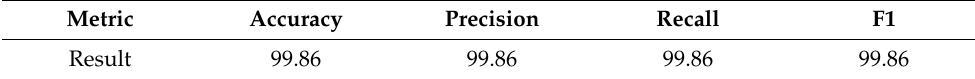
Table 1. Overall performance results (%) of the proposed LBP-NCA based model. Metric